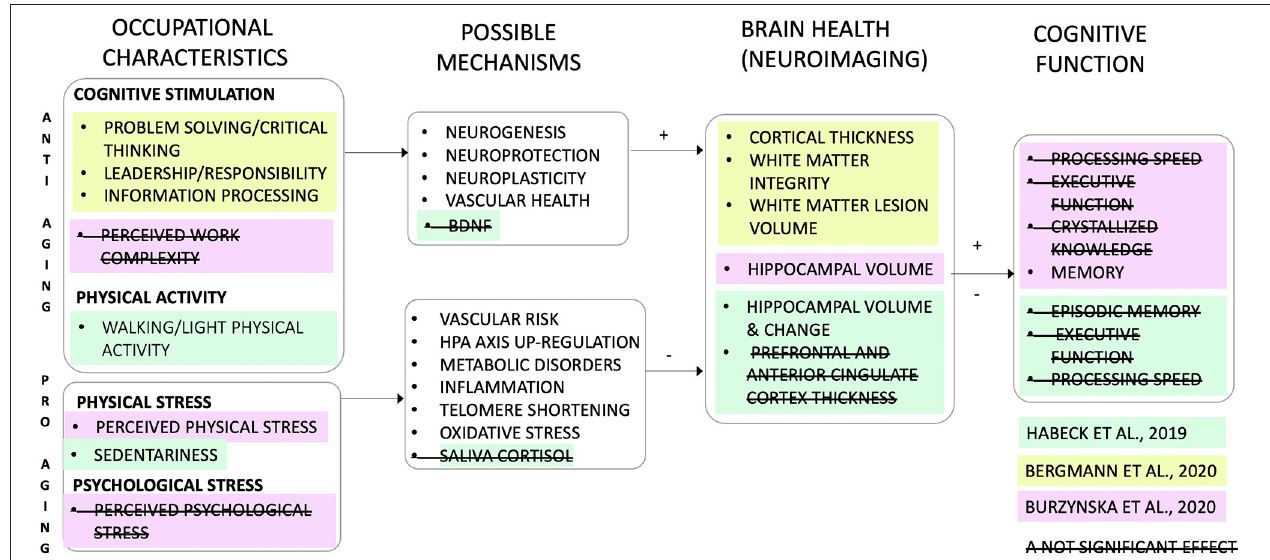
FIGURE 1 | The BOSS model (Brain aging: Occupational Stimulation and Stress; Burzynska et al., 2019): revised and extended. The model assumes two parallel and possibly opposing influences of occupations on brain health: the “anti-aging” (or neuroprotective) and “pro-aging” (or accelerating aging). The studies in the Research Topic “Work and Brain Health Across the Lifespan” add data supporting the anti-aging role of light physical activity and cognitive and social demands at work, and pro-aging effects of work-related sedentariness and perceived physical demands. One study included possible physiological mechanisms (i.e., peripheral blood levels of brain-derived neurotrophic factor, BDNF, and saliva cortisol), but the mediation results were not significant (Bergman et al.). The only significant association of work characteristics with cognition was the negative association between perceived physical demands and memory ( Burzynska et al.). Colors indicate the three studies in the Research Topic. Strikethrough indicate non-significant findings. Text in white indicate mechanisms that were not studied. HPA, hypothalamic–pituitary–adrenal